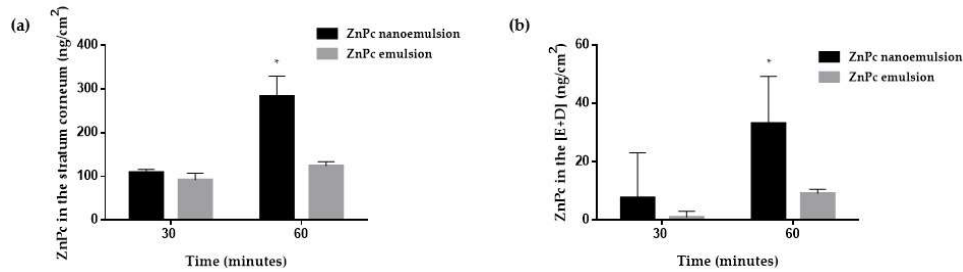
Figure 6. In vitro passive experiments: ZnPc recovered from ( a ) stratum corneum and ( b ) viable skin (E + D) after passive treatment of skin with ZnPc nanoemulsion (black columns) and emulsion (gray columns). * significant statistical difference (ANOVA with Tukey’s post hoc test, p < 0.05).